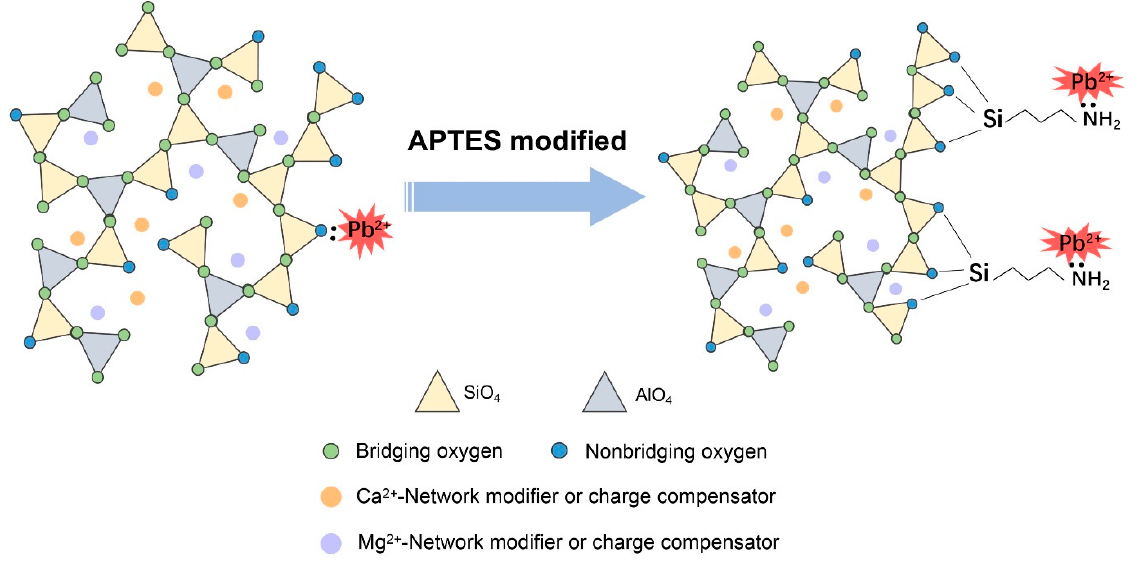
Figure 11. The proposed lead ion adsorption mechanism on the pristine and aminopropyl-modified slag.